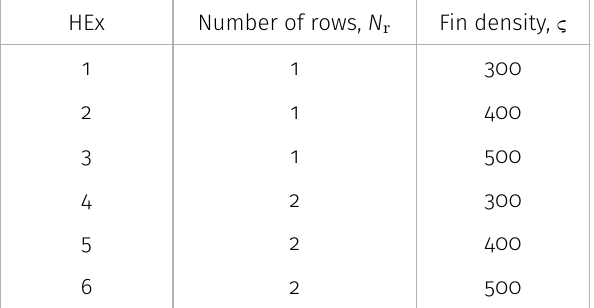
Table II. Summary of the variable geometric parameters of the heat exchanger samples. HEx Number of rows, N